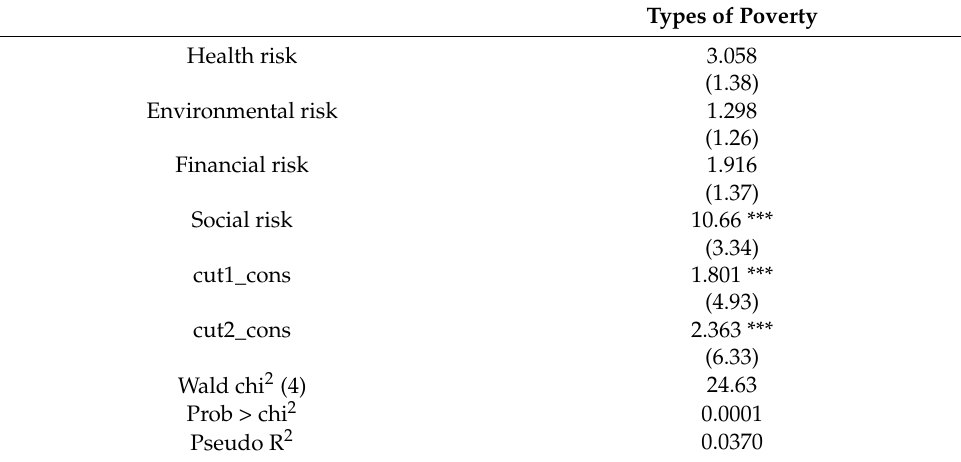
Table 3. Ordinal logistic regression results of the difference in livelihood risks faced by different types of poverty-stricken farmers.